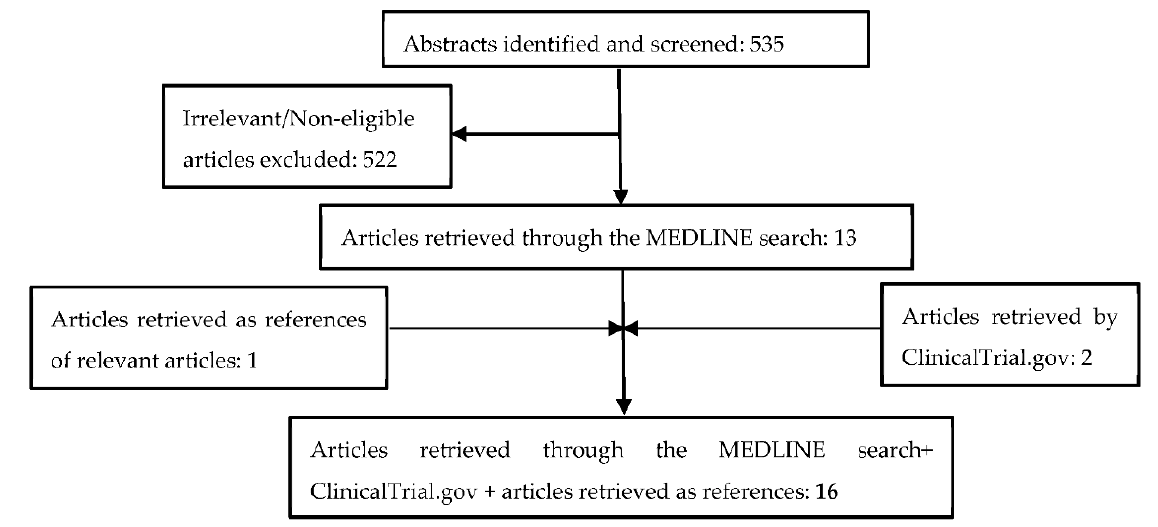
Figure 1. Consort flow diagram according to PRISMA 2009 guidelines.